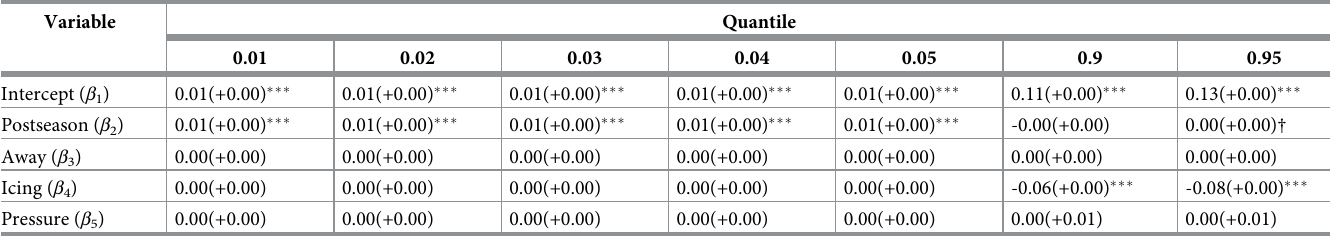
Table 4. Logistic quantile regression model of extra point